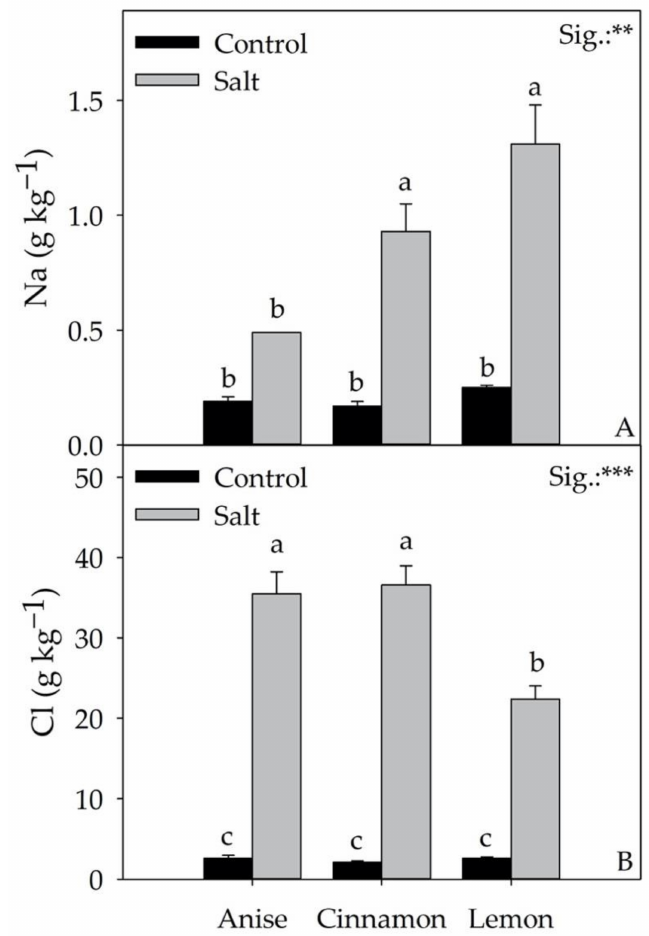
Figure 7. Effect of Cultivar × Stress on Na ( A ) and Cl ( B ) leaf concentration. Data are mean values ± standard error, n = 3. Statistical significance of the CV × S interaction was determined by Tukey HSD test for Cultivar and by t -Test for Stress. Different letters indicate significant mean differences. ** and *** denote non-significant or significant effects at p ≤ 0.01 and 0.001,